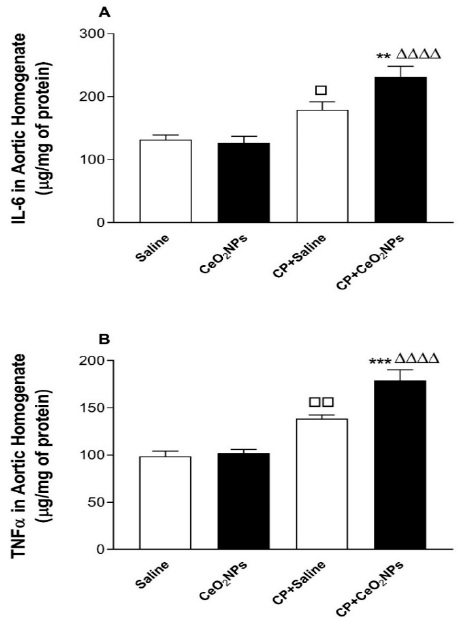
Figure 7. Aortic homogenates concentration of interleukin-6 (IL-6, ( A )) in rats intratracheally instilled with either saline (control, n = 8) or cerium oxide nanoparticles (CeO 2 NPs, n = 8) with ( n = 8) or without ( n = 8) cisplatin (CP) administration. Tumour necrosis factor- α (TNF α , ( B )) concentration in aortic homogenates of rats intratracheally instilled with either saline (n = 8) or CeO 2 NPs ( n = 8) with ( n = 8) or without ( n = 8) CP administration. ** P < 0.01 and *** P < 0.001 compared with CP (cid:3) P < 0.05 and + saline-treated group. ∆∆∆∆ P < 0.0001 compared with CeO 2 NPs-treated group. (cid:3)(cid:3) P < 0.01 compared with saline-treated group. Data are mean ±